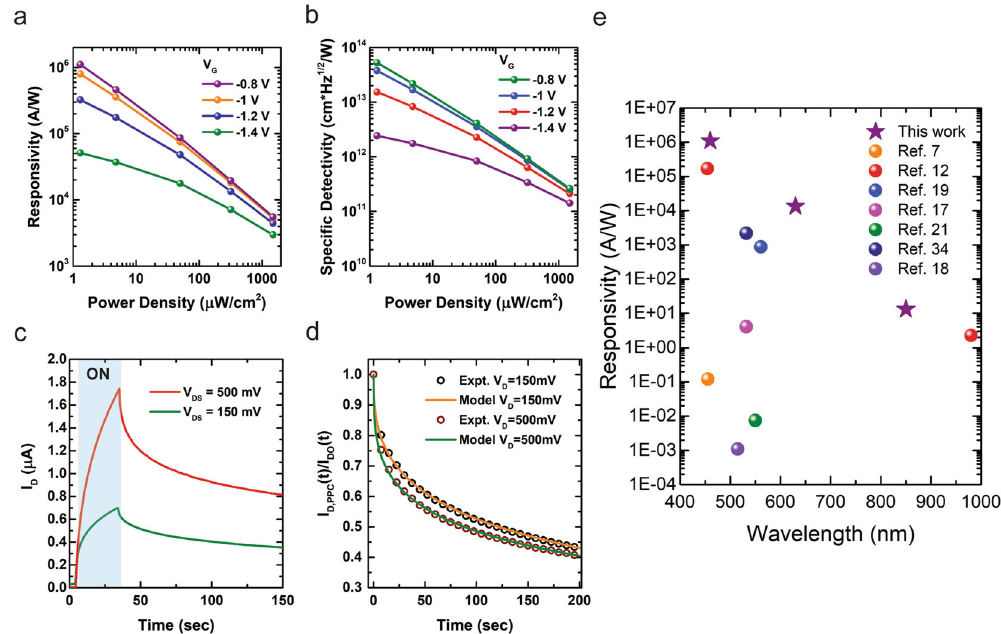
Fig. 5 Photodetection performance metrics. a Responsivity versus optical power density at V DS = 150 mV and different V G . b Speci fi c detectivity versus optical power density at V DS = 150 mV and different V G . c Photoswitching behavior with 30 s light pulse at 1.5 mV cm − 2 , V G at − 1.5 V, and V DS at 150 and 500 mV. d PPC model fi tting to the normalized decaying drain current ( I D ) after illumination at V DS = 150 and 500 mV. e Benchmarking of responsivity versus wavelength of multi-layer and monolayer MoS 2